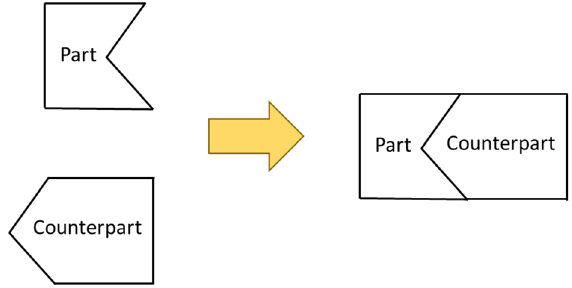
Figure 5. Illustration of part and counterpart .